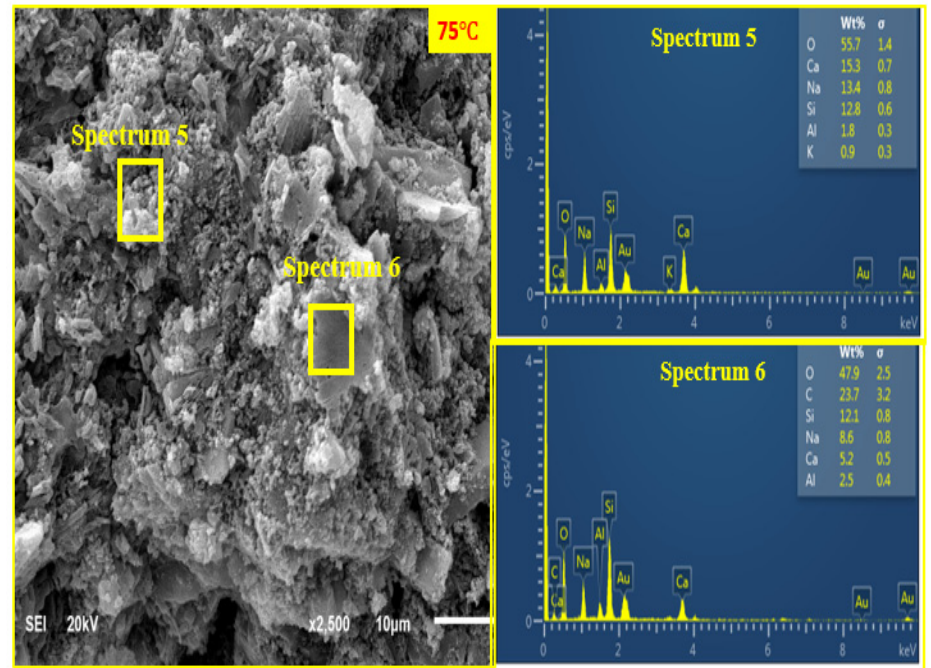
Figure 15. (SEM + EDX) of AANL cured at 7 5℃ .